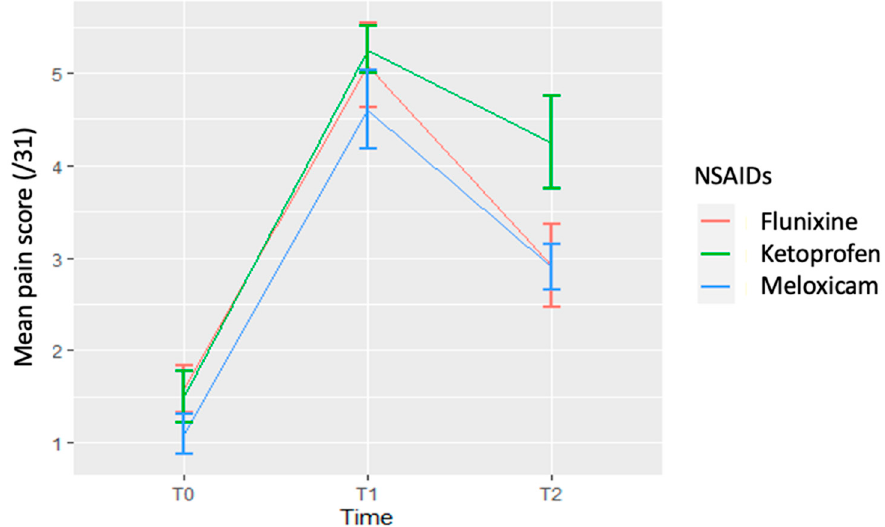
Figure 4. Mean pain scores depending on time and the administered NSAID. Data are reported as the mean and SEM.